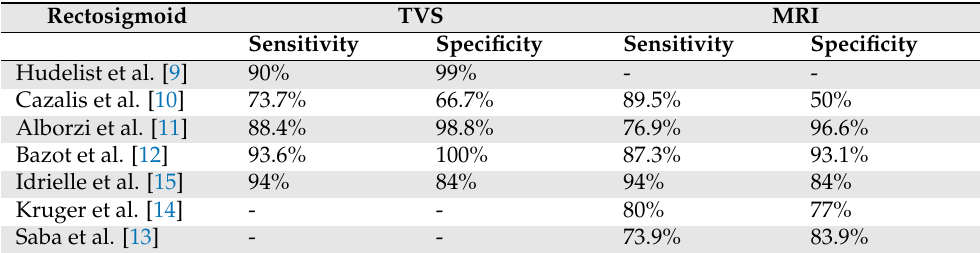
Table 6. The diagnostic accuracy of TVS and MRI in rectosigmoid DE (as reported in different studies). Rectosigmoid TVS